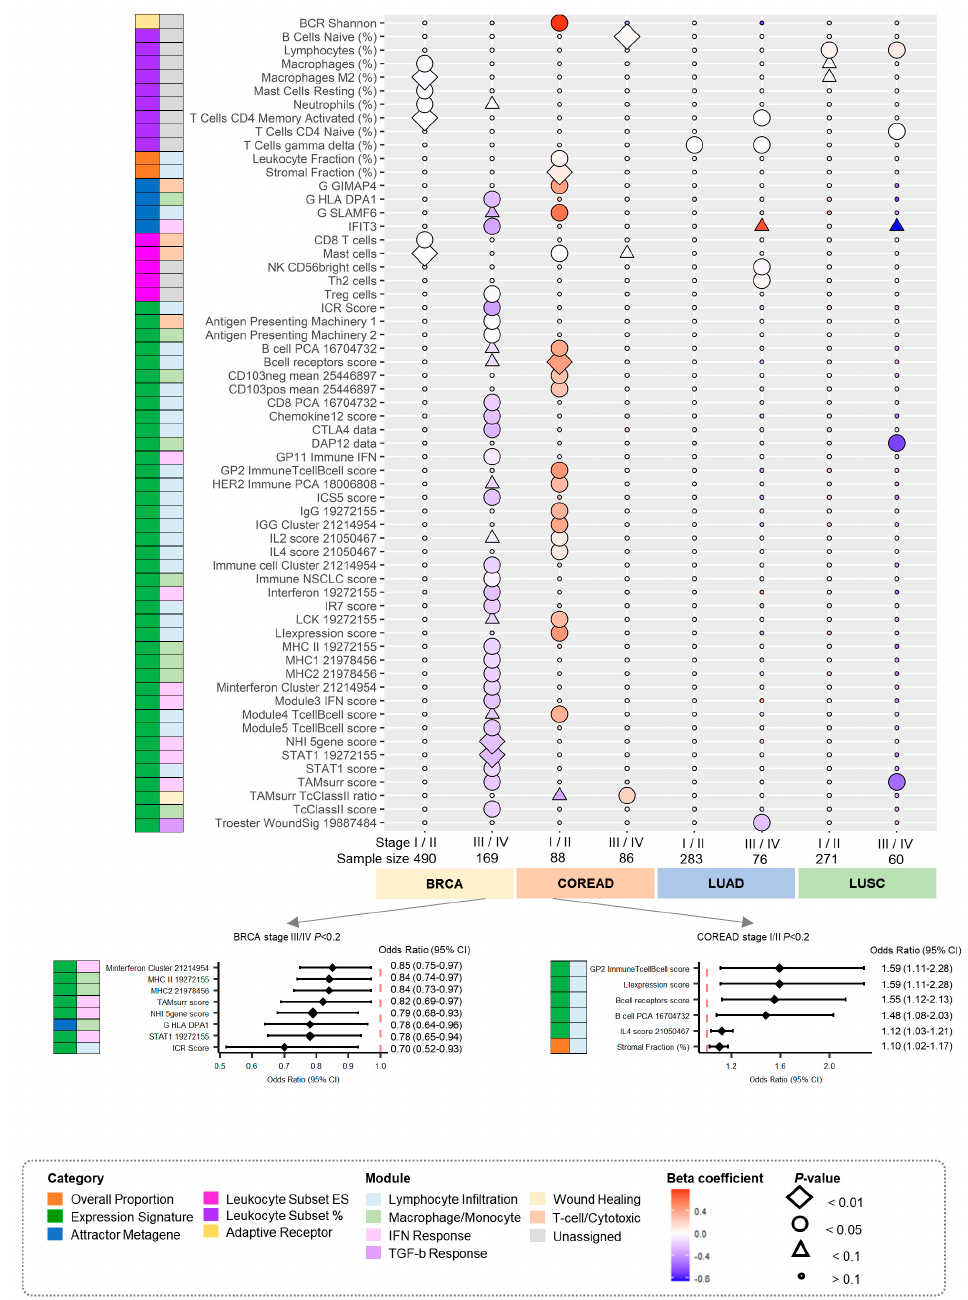
Figure 2. Stratified analyses by stage (early and advanced stages) between PRSs for cancers and immune traits. Immune traits were presented when a nominal p < 0.05. against at least one type of cancer, was observed. In the figure below, forest plots are presented when a nominal p < 0.02 in advanced stages of breast cancer and early stages of colorectal cancer, which were the most representative of the data. Abbreviations: BRCA, breast cancer; COREAD, colorectal cancer; LUAD, lung adenocarcinoma; LUSC, lung squamous cell carcinoma; PRS, polygenic risk